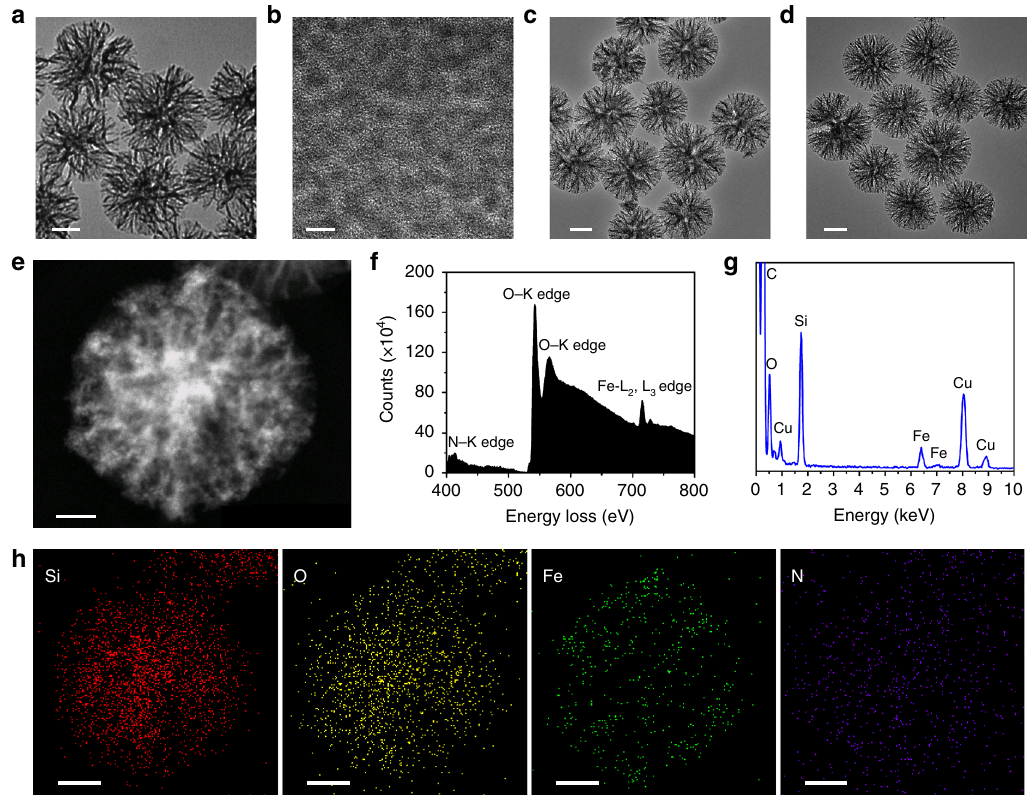
Fig. 2 Structural and compositional characterizations of DMSN supports, FD NCs, and GFD NCs. TEM images of a DMSN supports, b ultrasmall Fe 3 O 4 NPs, c FD NCs, and d GFD NCs. Scale bar : a , c , d : 100 nm; b : 5 nm. e Dark- fi eld image, f EELS, g EDS, and h corresponding area-elemental mappings of the sequential GFD NCs. Scale bar : 50